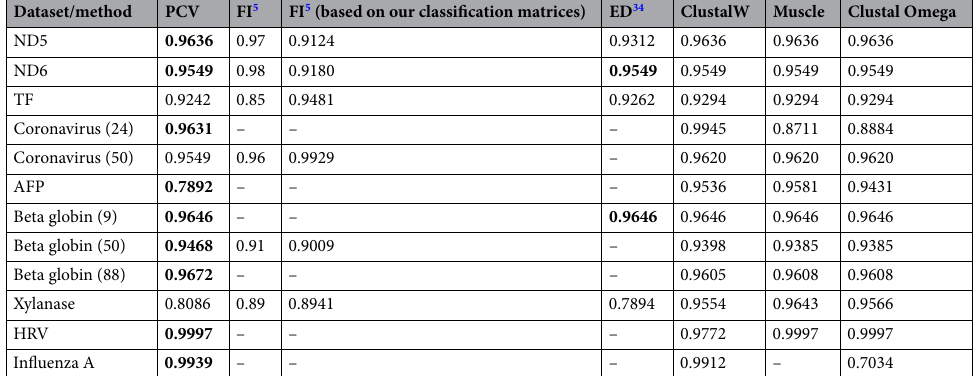
Table 5. Comparison of PCV, ED, Fuzzy integral based method and three alignment-based methods ClustalW, Clustal Omega, and Muscle based on AUC values for 12 benchmark datasets. Significant values are in